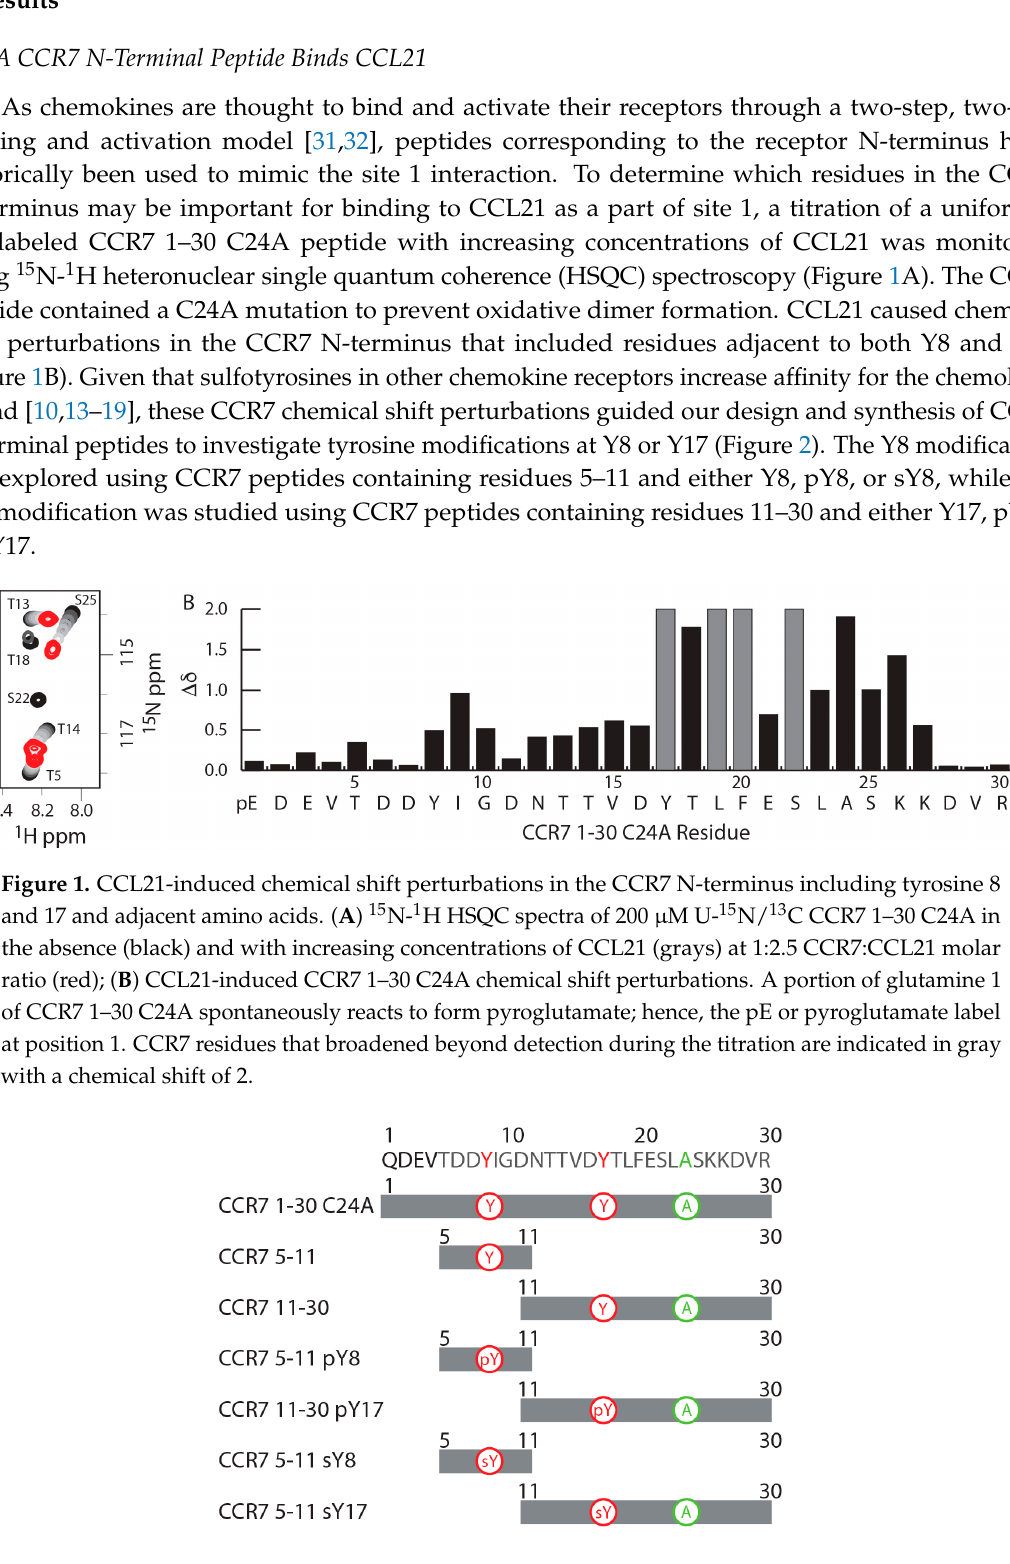
Figure 2. Schematic of the various CCR7 N-terminal peptides used in this study. CCR7 peptides correspond to the sequence of the mature CCR7 N-terminus. Those peptides including residue 24 have a C24A mutation to prevent oxidative peptide dimer formation. Tyrosine posttranslational modifications are as indicated.